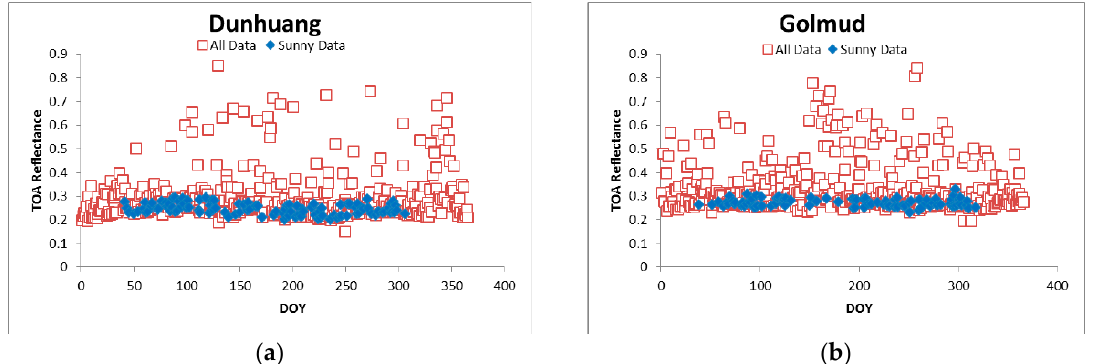
Figure 6. TOA reflectance of all images (red hollow box) and images of sunny days with variation coefficient (VC) less than 4% (blue solid rhombus): ( a ) Dunhuang; ( b ) Golmud.